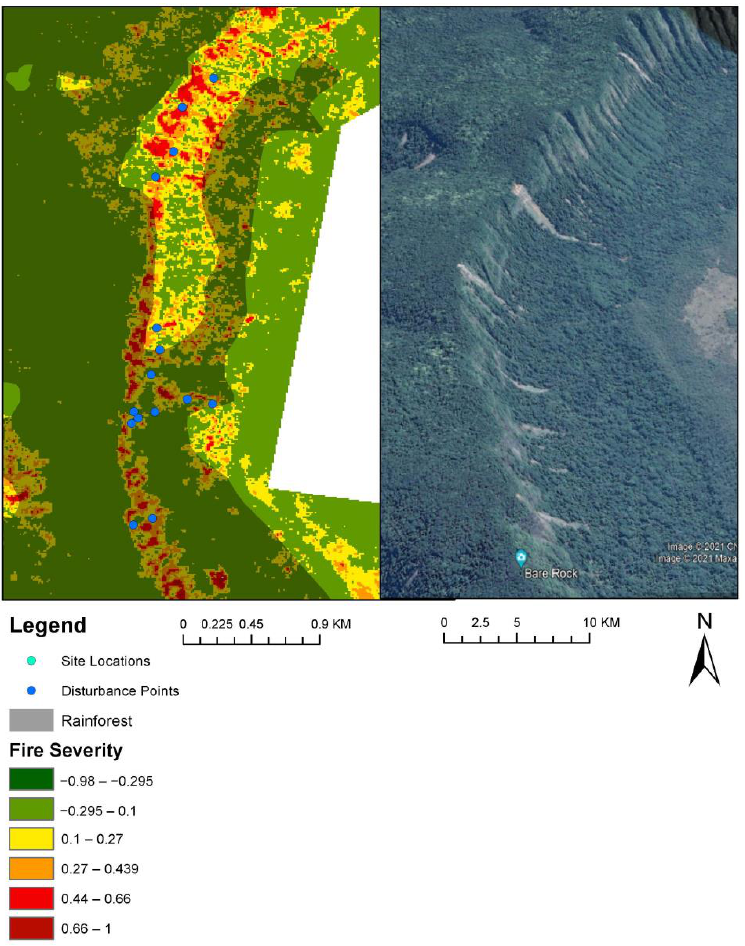
Figure 6. Disturbance at Main Range NP showing the extent of burns (dNBR raster) and disturbance points on left. Rainforest polygon overlayed. Google Earth satellite imagery of Main Range landslips disturbance on right.